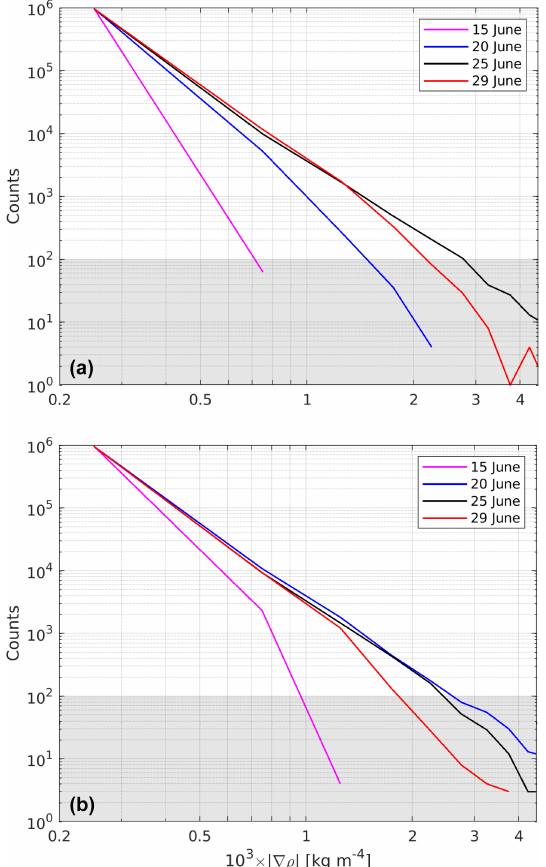
Figure 6. R100: frequency distribution of |∇ ρ | in the top layer. The initial and open boundary conditions for R100 were provided by (a) R500 and (b) R500_NF, respectively. The values were binned in 10 intervals of 0 . 5 × 10 − 3 kgm − 4 width between 0 and 5 × 10 − 3 kgm − 4 . Counts < 100 (gray shaded) representing less than 0.1% of the total number of horizontal grid points were not considered